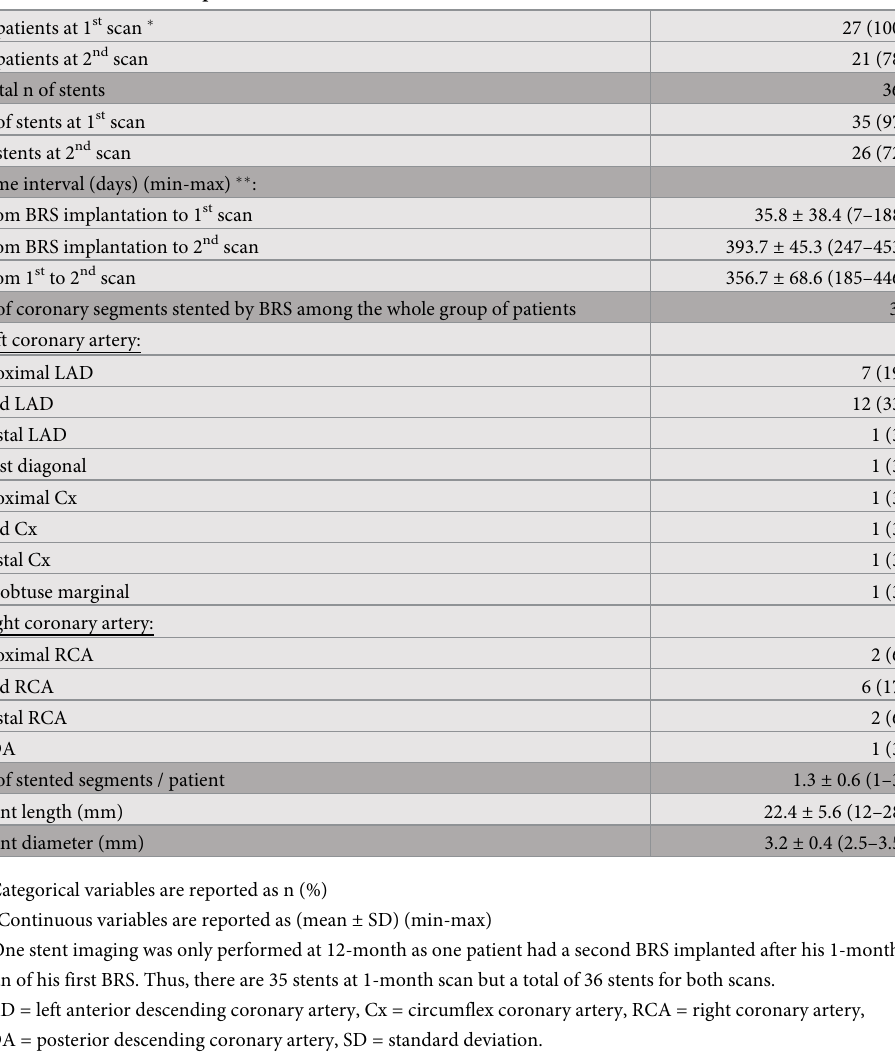
than 5 mm (4 patients, 4 stents, 5 blocks).